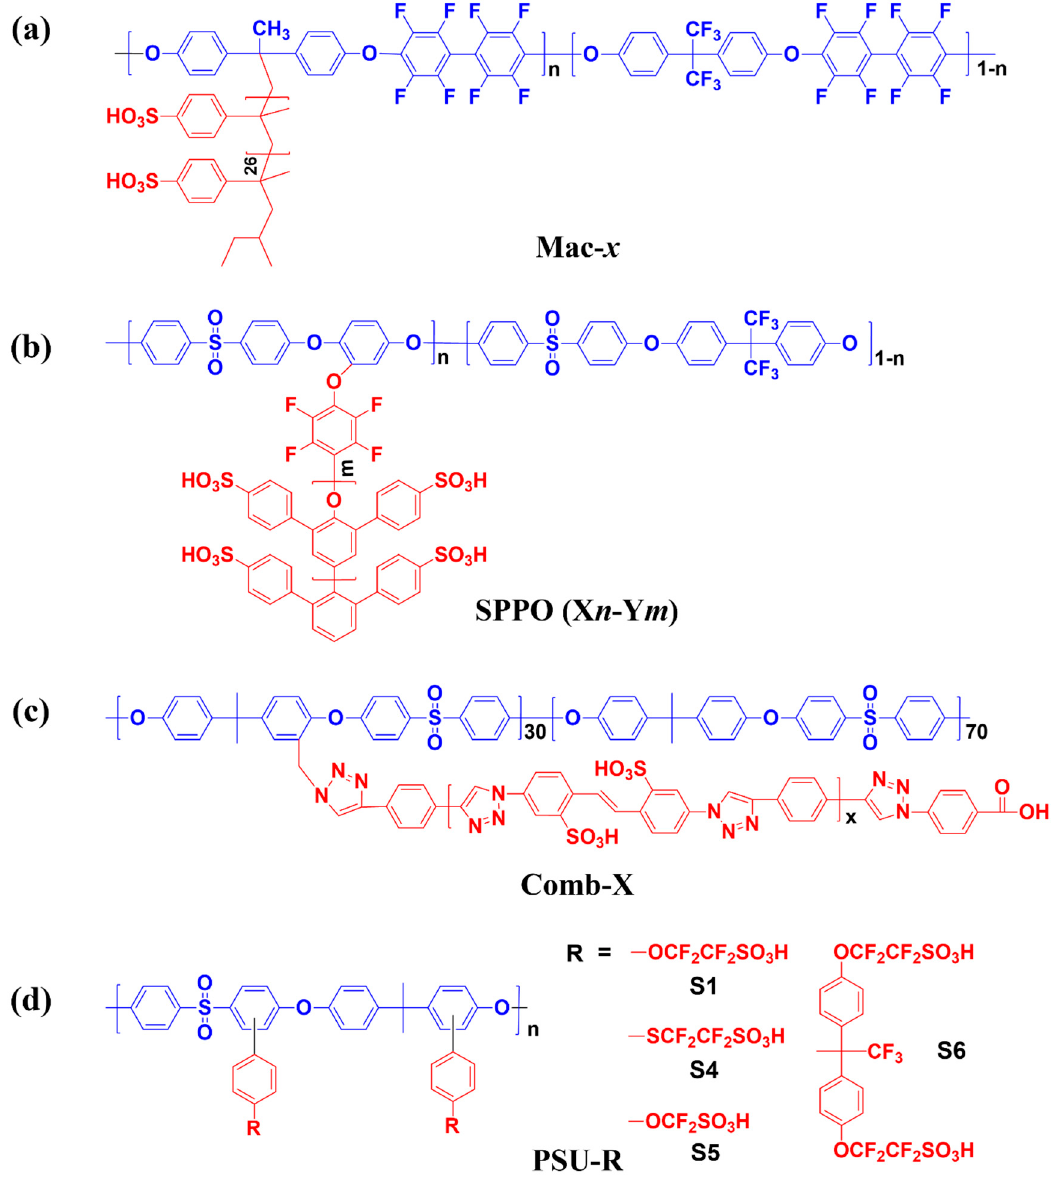
Figure 5. Representative chemical structures of sulfonated hydrocarbon-based graft/comb-shaped copolymers. ( a ) Mac- x , ( b ) SPPO (X n -Y m ), ( c ) Comb-X and ( d ) PSU-R [49,73,80,82].